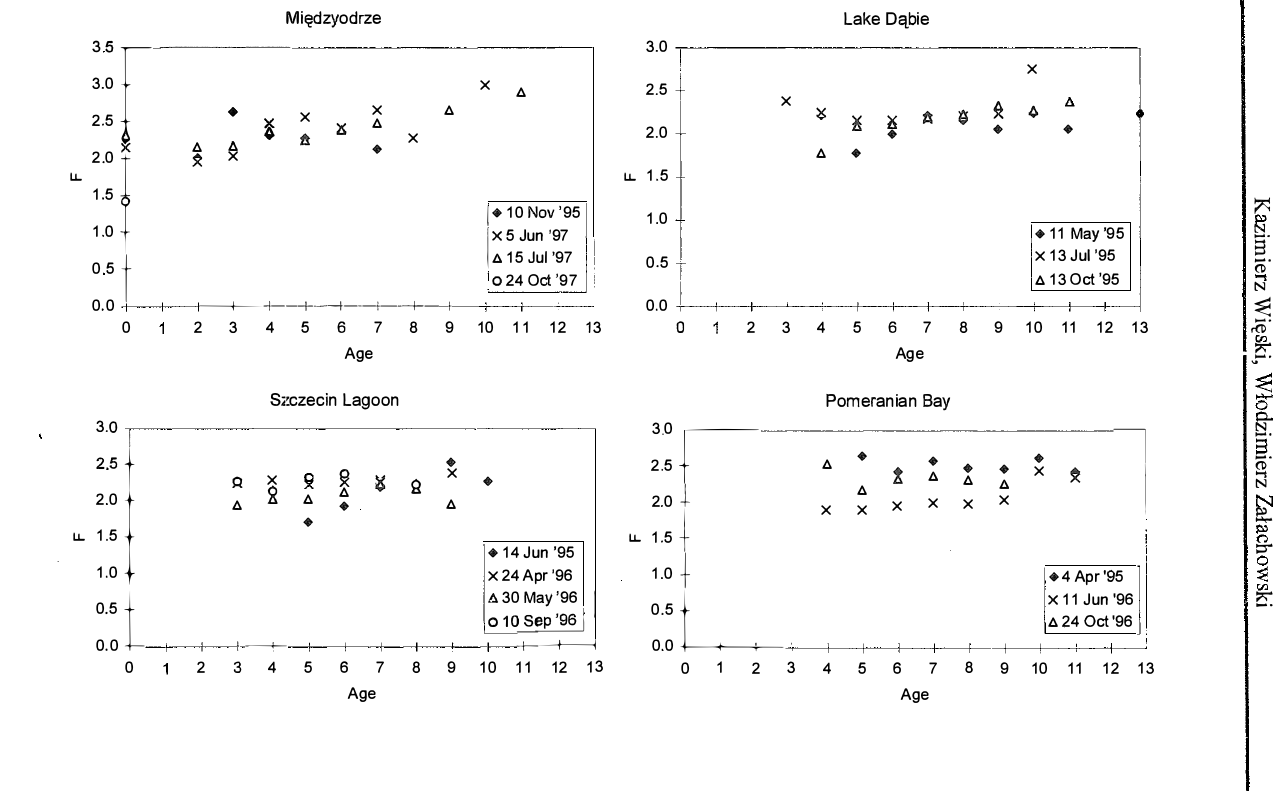
Fig. 3. Date of capture-dependent changes in the Fulton